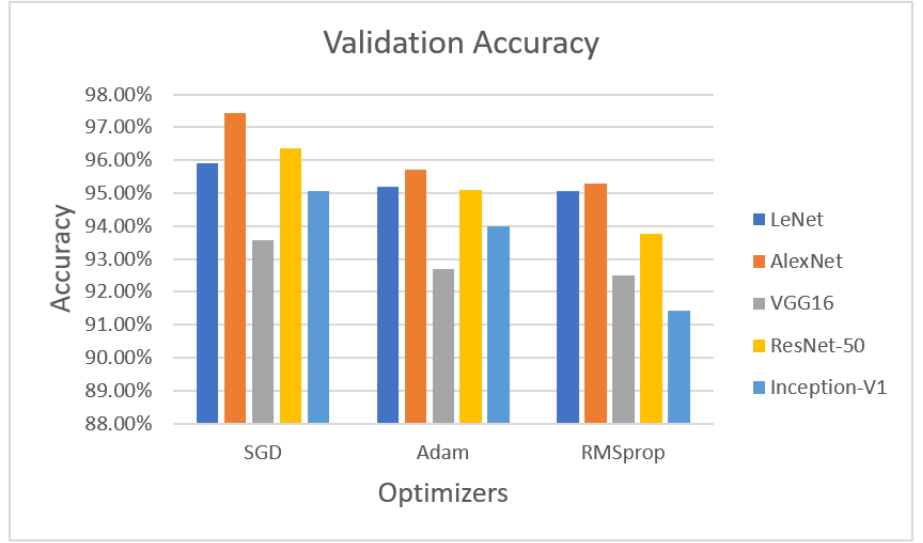
Figure 3. Performance evaluation with statistical parameters for LeNet, AlexNet, VGG16, ResNet-50, and Inception-V1 (validation accuracy).